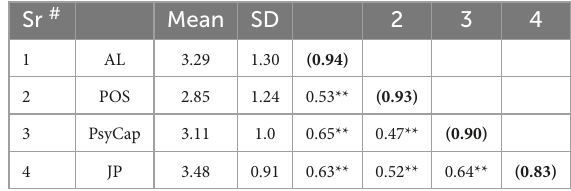
TABLE 3 Correlations mean and standard deviation of study